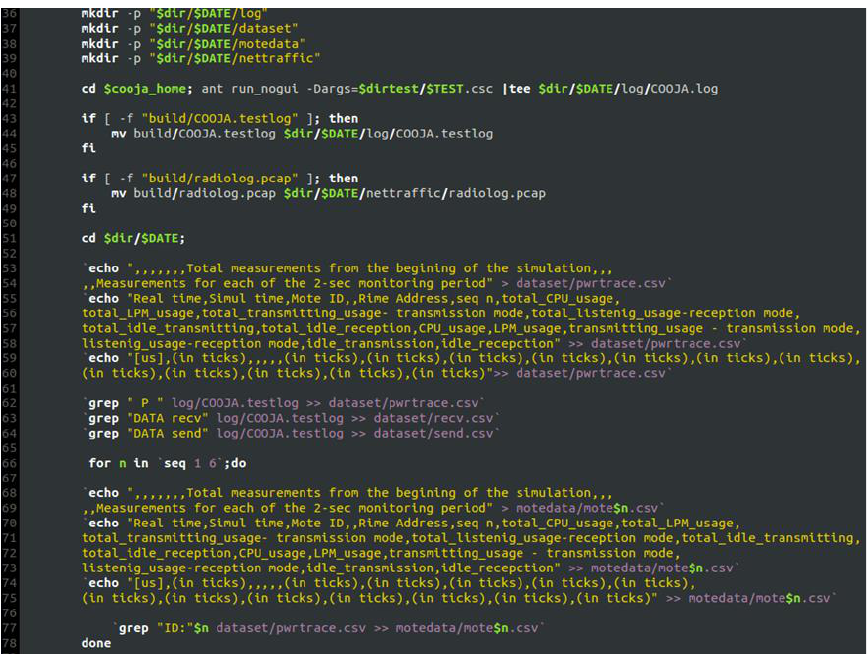
Figure 8. Extract of the “IoT_Simul.sh” bash file.